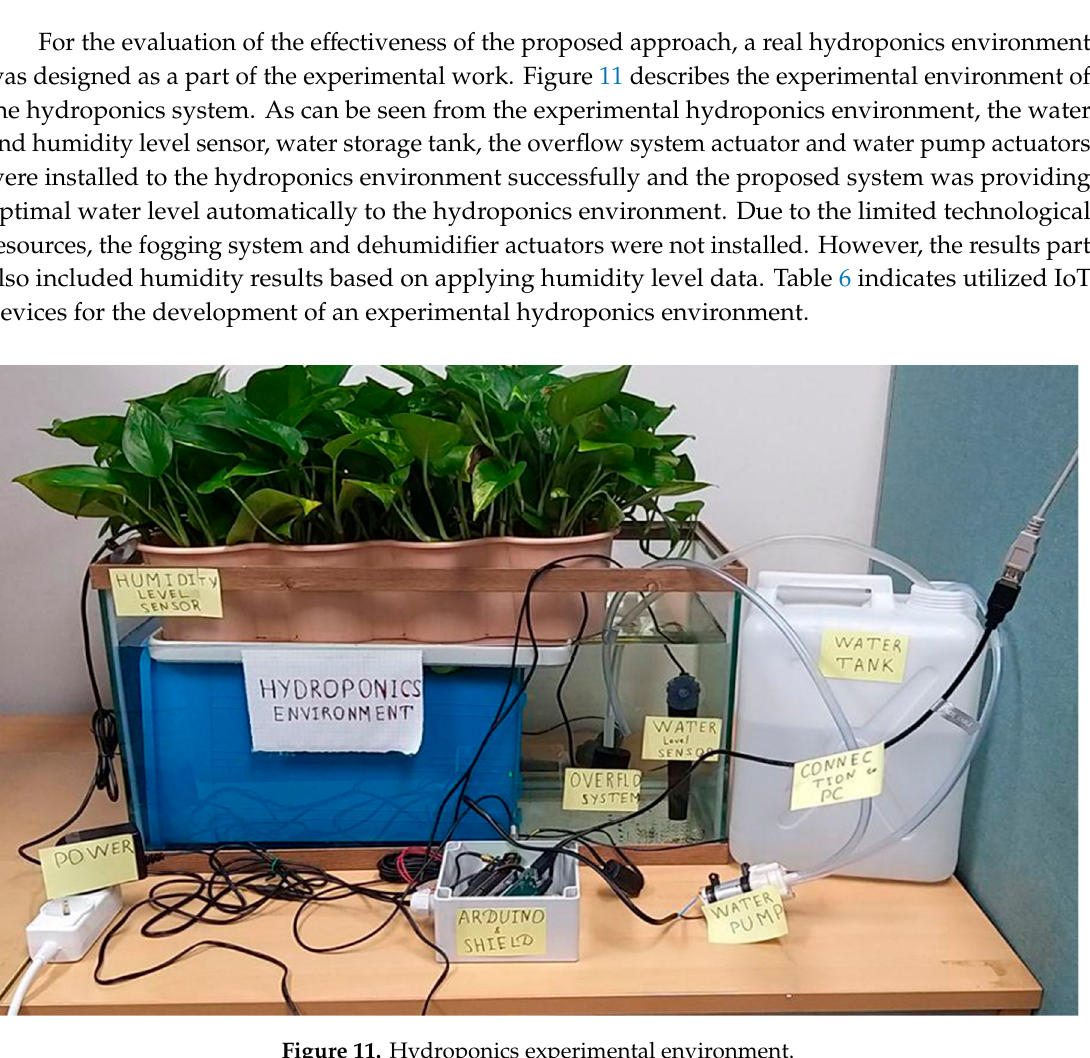
Table 6. Description of IoT devices for the experimental hydroponics environment.